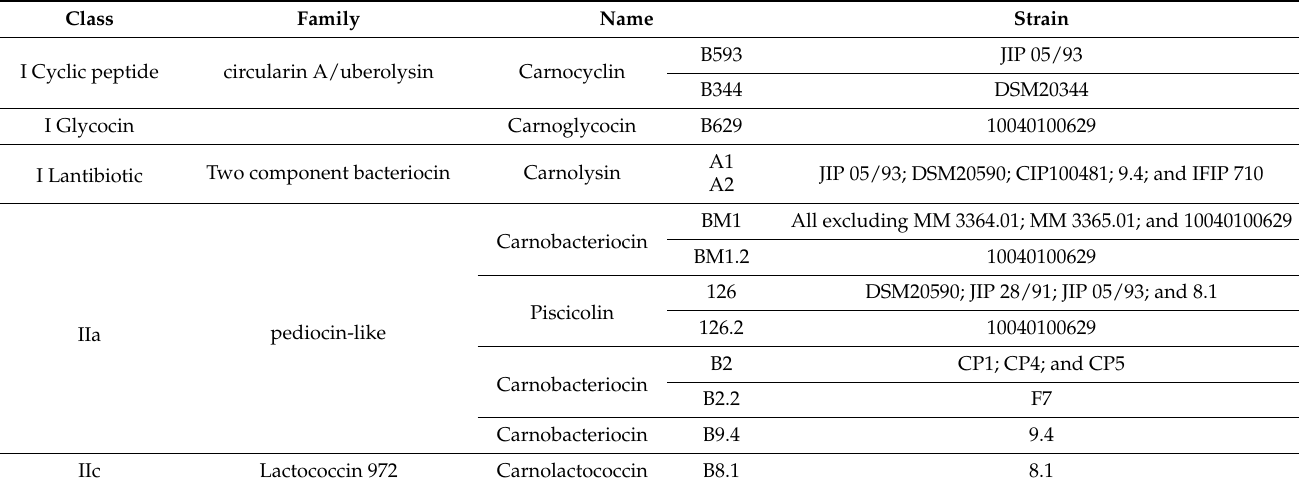
Table 1. Bacteriocins predicted from the genome of 29 strains of C. maltaromaticum